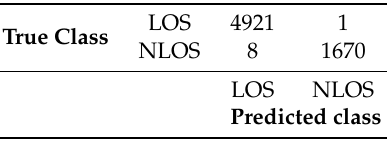
Table 4. Confusion matrix of the LOS/NLOS classifier.